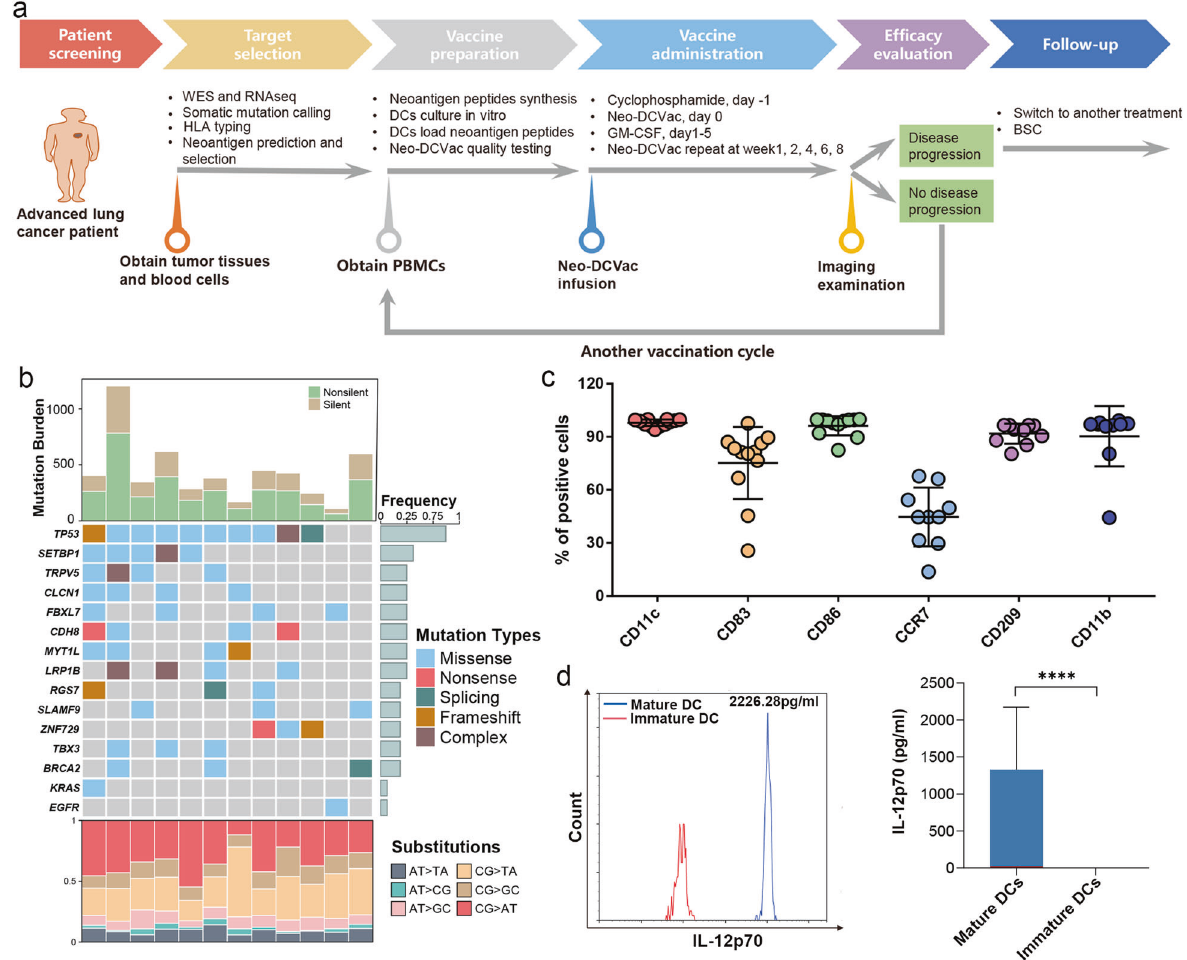
Fig. 1 Diagram of vaccine work fl ow, overall mutational landscape, and analysis of DC vaccine products. a The treatment protocol of Neo- DCVac for patients with advanced lung cancer. BSC best support care. b The overall mutational landscape of the tumors from the 12 enrolled patients. Top, mutation burden; bottom, distribution of nucleotide changes; middle, mutated genes in the 12 lung cancer patients, arranged by the numbers of recurrences. c Percentage of output DCs expressing CD11c, CD83, CD86, CCR7, CD209, and CD11b in the vaccine products ( n = 12). d Representative example of IL-12p70 secretion in immature and mature DCs ( n = 12). All the data are shown as the mean ± s.e.m. (**** P <